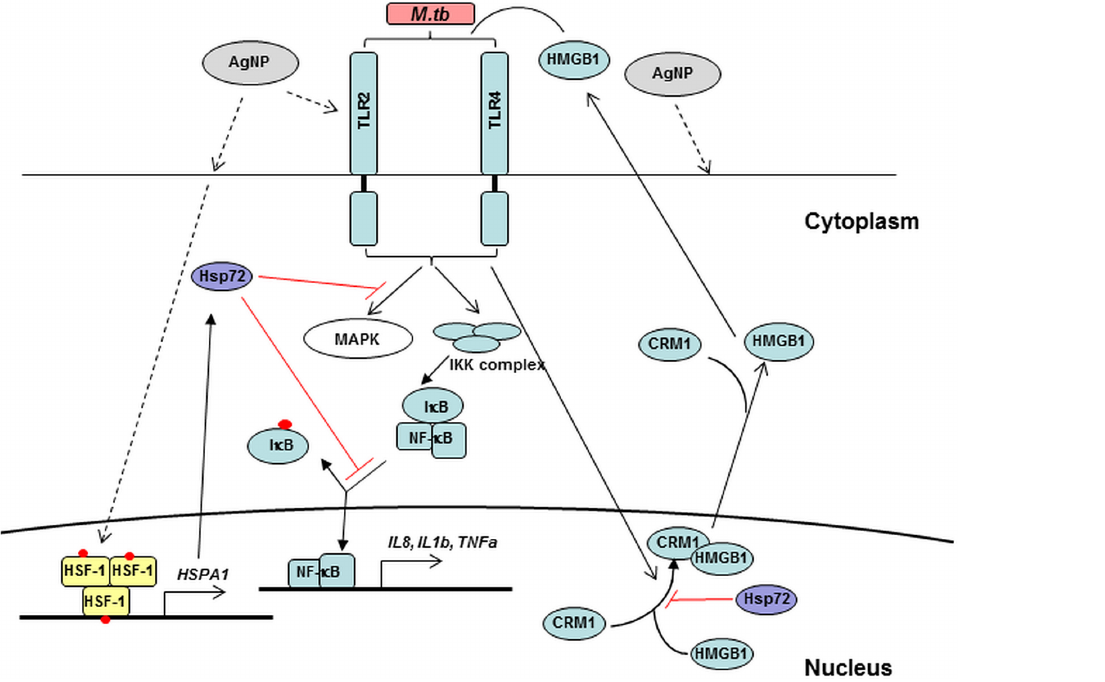
Fig 12. Schematic of hypothetical mechanisms of AgNP-induced suppression of M . tb -induced TLR signaling and proinflammatory responses. M . tb binds to TLRs and activates MAPK and NF- κ B leading to the expression of cytokines such as IL-1 β and TNF- α . IKK complex phosphorylates I κ B which leads to its dissociation from the NF- κ B complex followed by translocation of NF- κ B into the nucleus where NF- κ B binds and activates target genes. M . tb induces the cytoplasmic translocation of HMBG1 protein by chromosome region maintenance 1 (CRM1)-dependent transport and secretion. HMBG1 binds to TLR receptors and activates MAPK and NF- κ B pathways [45]. AgNP, which are thought to enter cells via receptor-mediated endocytosis (dashed lines) upregulate the expression of HSPA1A that encodes Hsp72 via the activation and binding of heat shock factor (HSF), the major transcription factor that binds to the promoter of HSPA1A . Intracellular Hsp72 potentially suppresses the cytoplasmic transport and secretion of HMGB1 proteins as well as the activation of MAPK and NF- κ B pathways [66] leading to the suppression of M . tb -induced cytokine expression in presence of AgNP. Hsp72 can be secreted and bind to TLR4 and activate MAPK and NF- κ B pathways [88]. Red dots represent phosphorylation of HSF-1 and I κ B proteins. The potential inhibitory effects of Hsp72 are shown with red solid lines. Signaling pathways that are reported to be induced by specific ligand receptor interactions and the more hypothetical pathways are shown with solid and dashed lines,